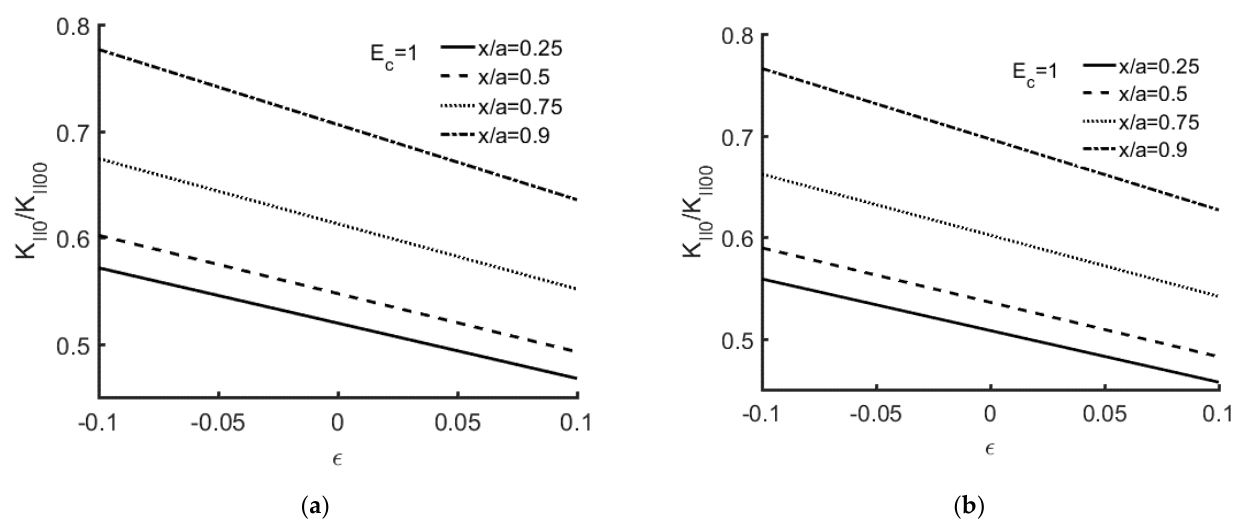
Figure 5. ( a ) K II0 /K II00 versus ε with x/a = 0.25, 0.5, 0.75, 0.9 for Ec = 1 The orthotropic material listed in Table 1; ( b ) K II0 /K II00 versus ε with x/a = 0.25, 0.5, 0.75, 0.9 for Ec = 1. The isotropic material listed in Table 2.